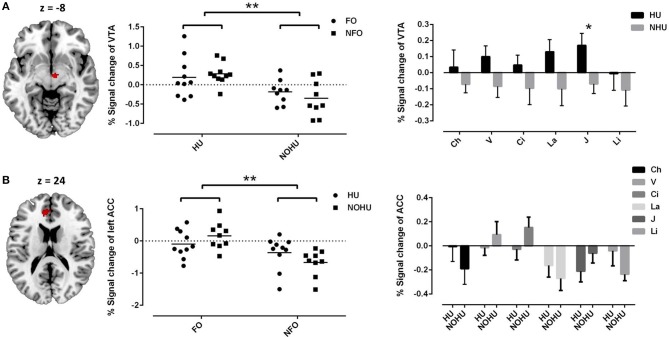
(A) VTA activation represents the main effect of hunger; The mean signal change for FO or NFO group and for individual odors of HU and NOHU participants are shown as a scatter plot (individual data and mean) and bar chart (mean and standard error of the mean), separately; (B) left ACC activation represents the main effect of odor type (FO vs. NFO). The mean signal change for FO or NFO group and for individual odors rated by HU and NOHU participants are shown as the scatter plot (individual data and mean) and bar chart (mean and standard error of the mean), separately; ACC, anterior cingulate cortex; VTA, ventral tegmental area. FO, Food Odors; NFO, Non-food Odors; HU, Hunger group; NOHU, Non-hunger group; V, Vanilla; Ci, Cinnamon; La, Lavender; J, Jasmine; Li, Lily of the Valley. Asterisks indicate significant differences: *p < 0.05; **p < 0.01.